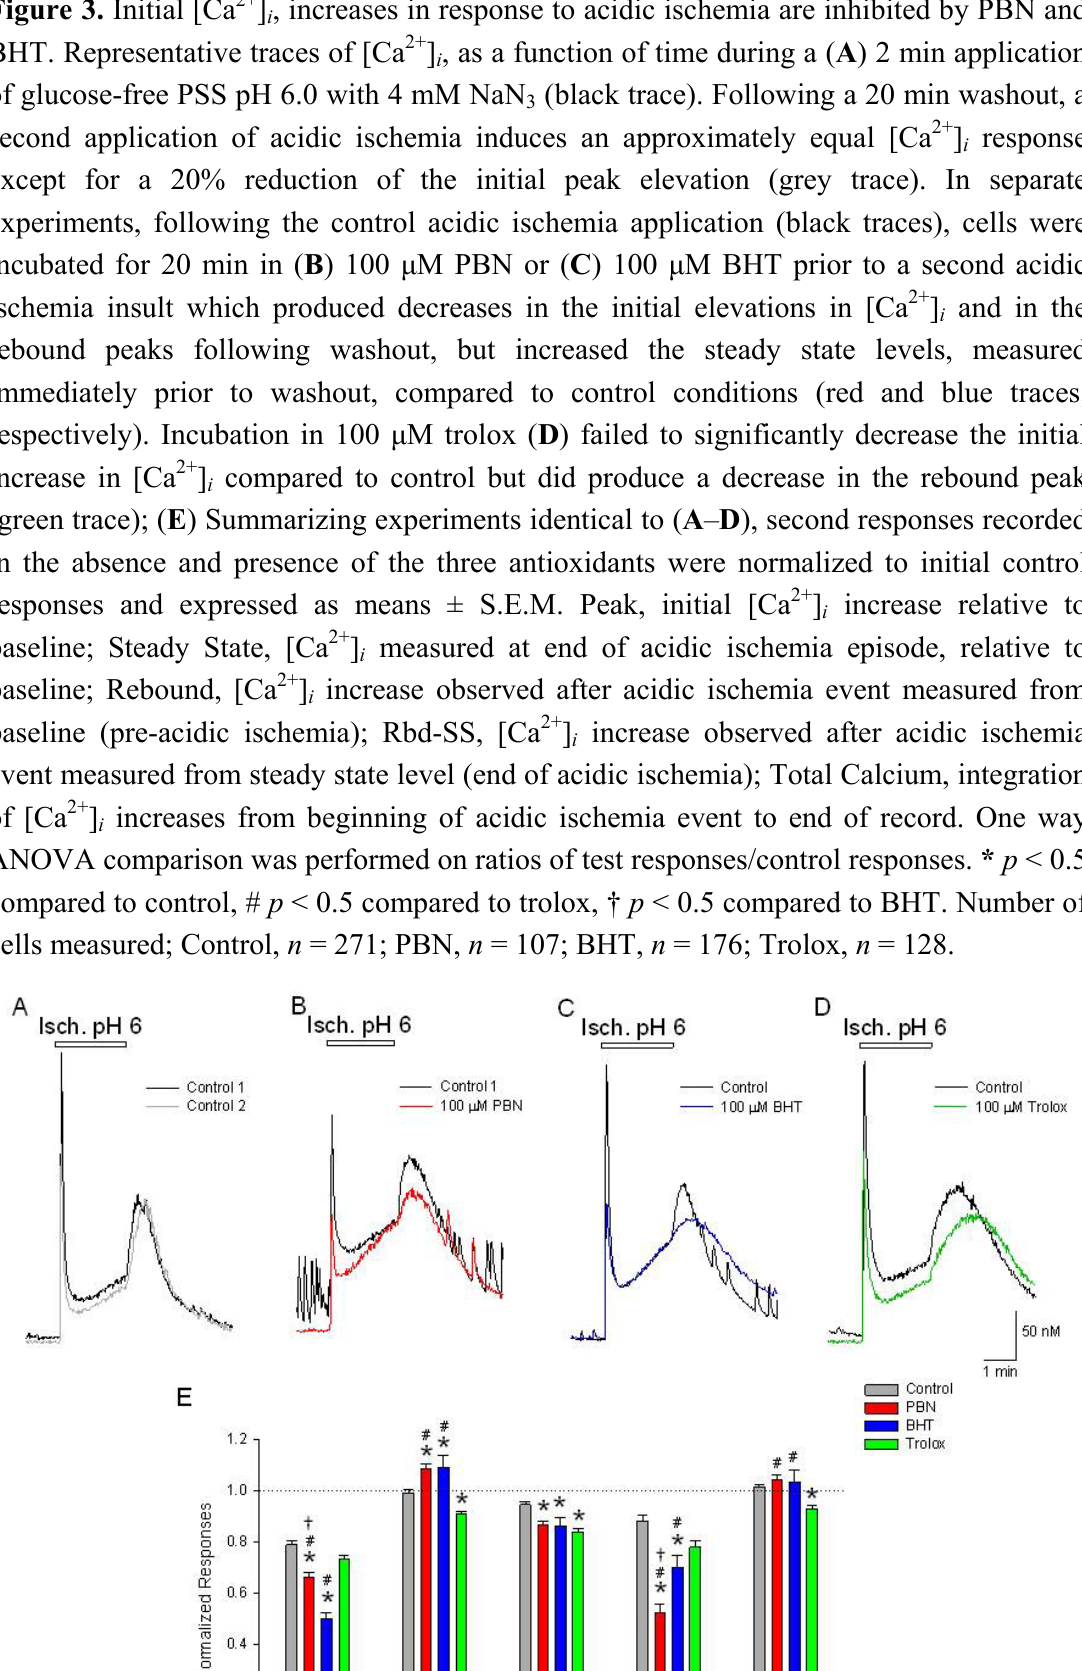
Figure 3. Initial [Ca 2+ ] , increases in response to acidic ischemia are inhibited by PBN and i , as a function of time during a ( A ) 2 min BHT. Representative traces of [Ca 2+ ] i